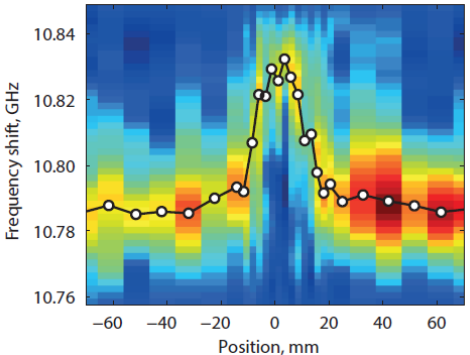
Figure 5 . Measured normalized Brillouin gain as a function of correlation peak position and frequency offset between the pump and signal waves [43]. A magnified view of a 130-mm-long section of fiber is presented. The section is located at the far end of a 17.5-km-long fiber under test. A 14-mm-wide hot-spot is clearly identified in the measurements. Reproduced with permission from [43], Andrey Denisov, EPFL, 2015.